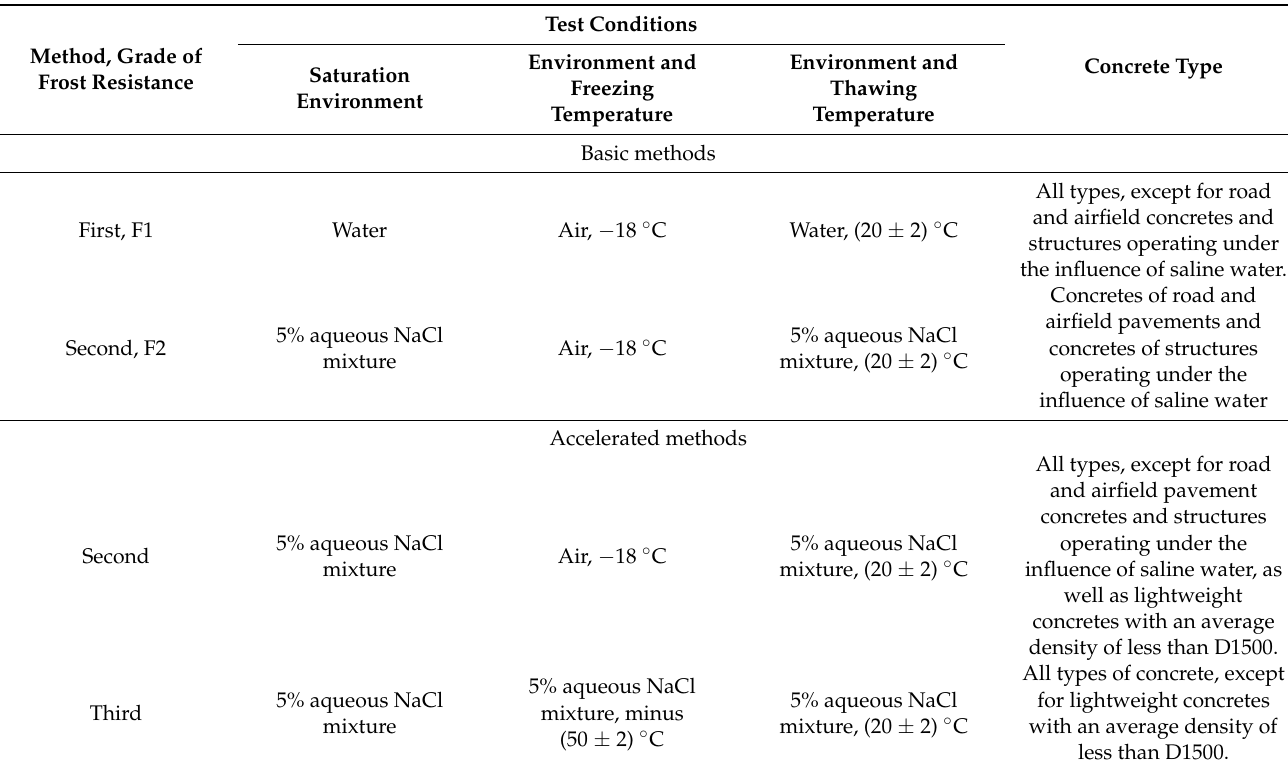
Table 4. Test conditions for determining the frost resistance [8].